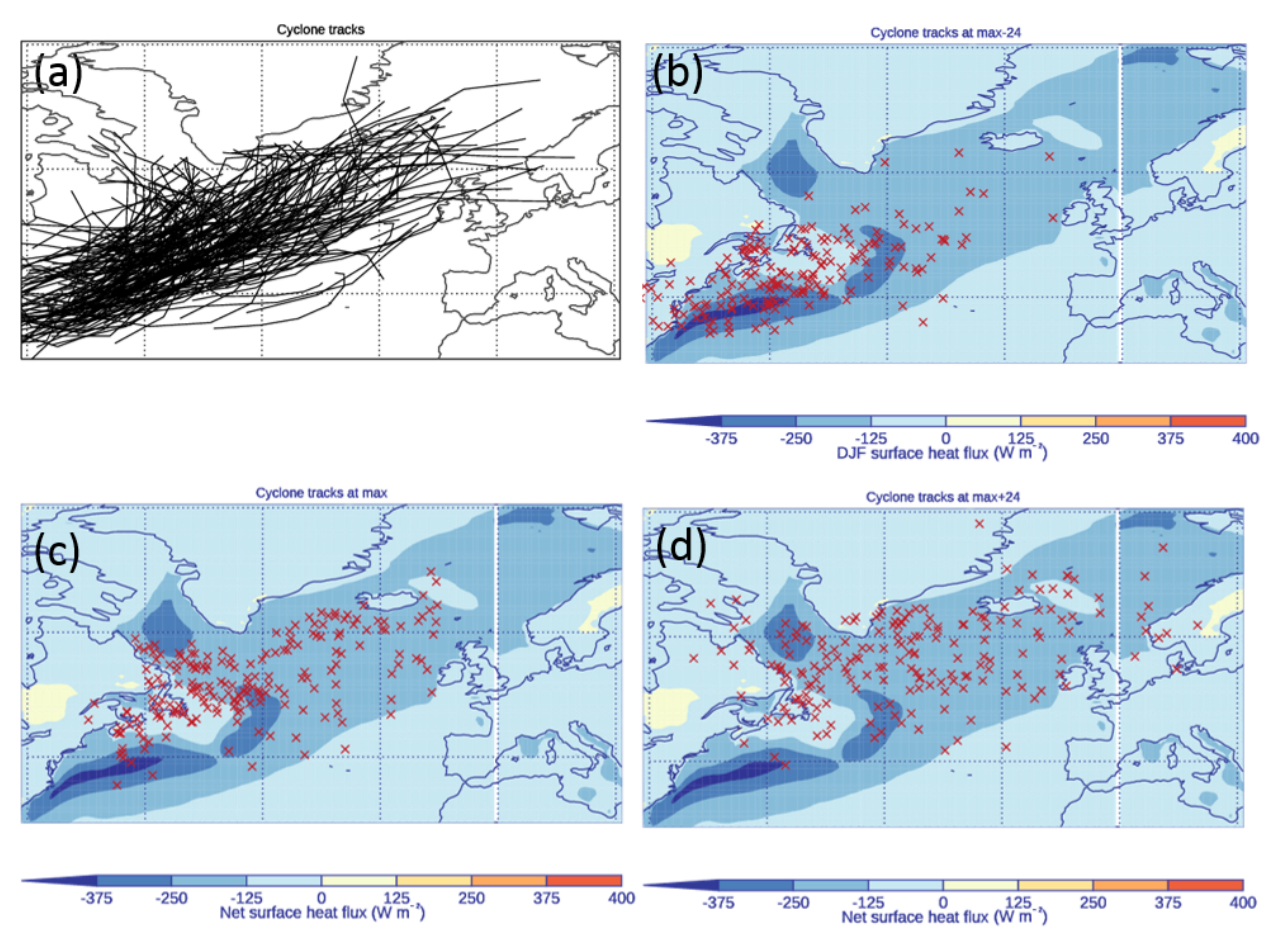
Figure 1. (a) Tracks of the 200 most intense DJF North Atlantic storms between December 1989 and February 2009 (black). Position of the cyclones (b) 24h before maximum intensity (max − 24), (c) at maximum intensity (max) and (d) 24h after maximum intensity (max + 24; red crosses). Overlaid on the DJF North Atlantic 1989–2015 net surface heat flux climatology, Q N (Wm − 2